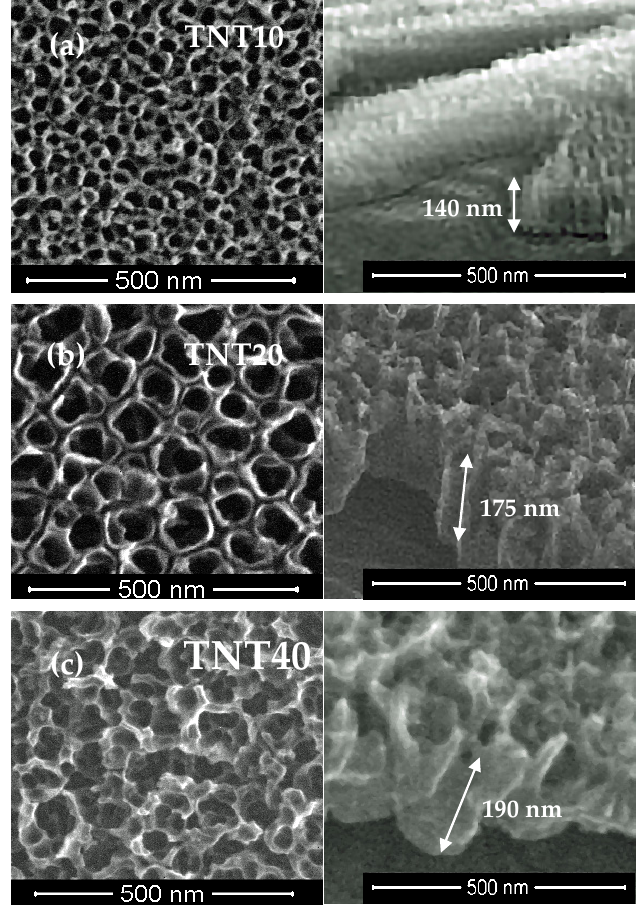
Figure 1. SEM images (top view and cross section) of the nanoporous coating (TNT10 ( a )), the nanotubular coating (TNT20 ( b )), and the nanosponge-like system (TNT40 ( c )) on the surface of the Ti6Al4V alloy samples.